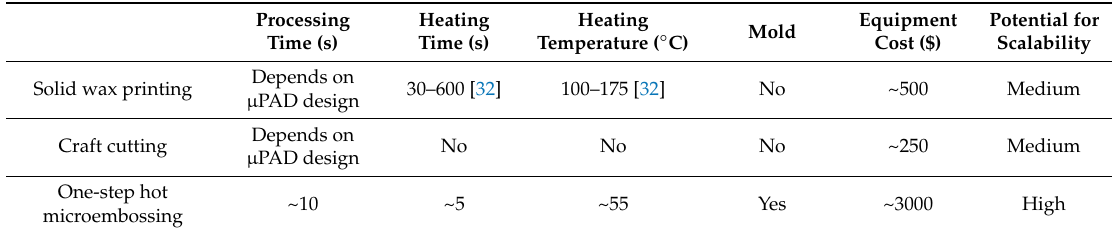
Table 1. Comparison between commonly used techniques and proposed method.